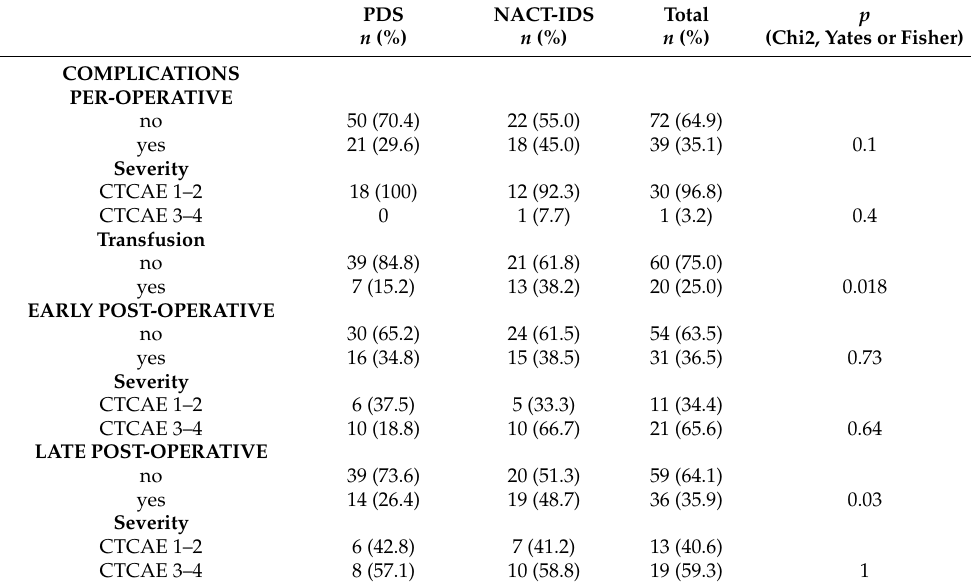
Table 3. Comparison of the PDS and NACT-IDS populations